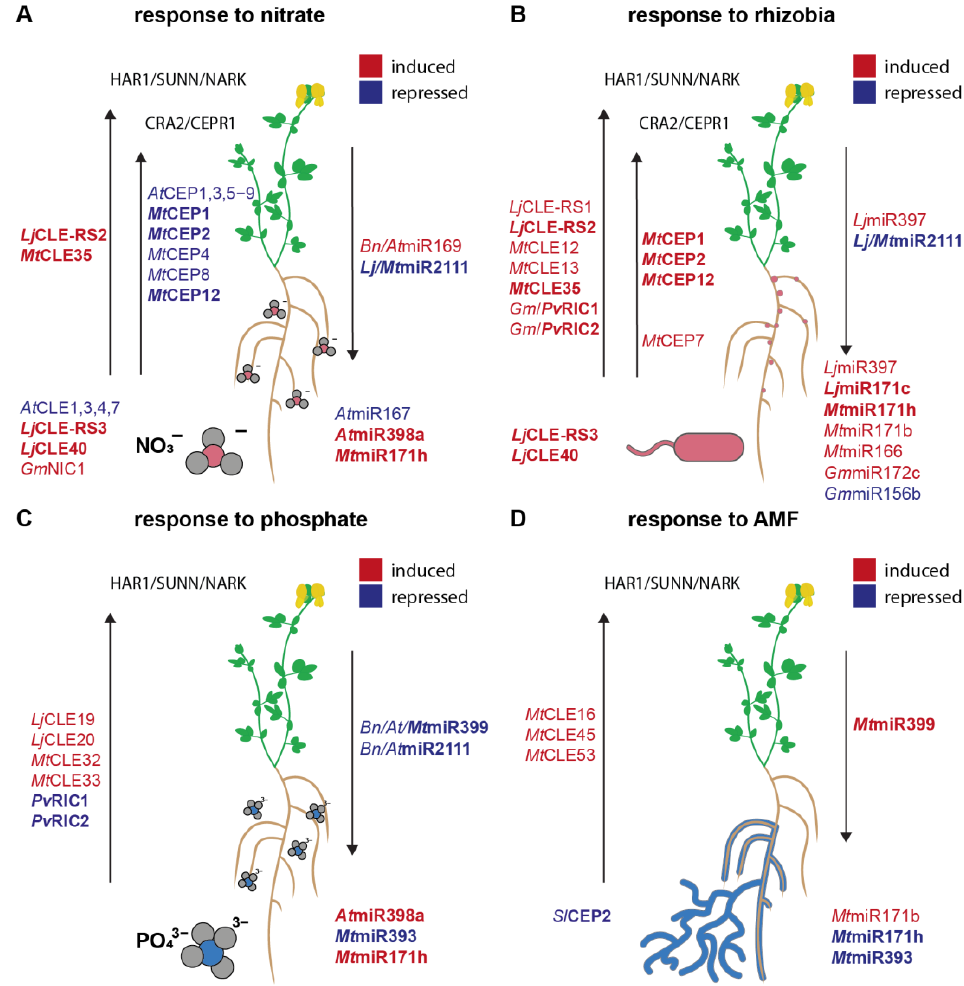
Figure 1. Nutrient homeostasis and acquisition mechanisms involve regulation by peptide hormones and miRNAs. CLE and CEP peptides and miRNAs responding to ( A ) N availability, ( B ) rhizobia , ( C ) P availability and ( D ) arbuscular mycorrhizal fungi. Molecules that are induced or repressed by a respective stimulus are displayed in red or blue, respectively. Molecules that are responsive to more than one stimulus are in bold. Arrows indicate shoot-to-root or root-to-shoot translocation of mobile molecules. Specific responses are mediated by the shoot localized leucine-rich repeat receptor-like kinases HAR1/SUNN/NARK and CRA2/CEPR1. Lj , Lotus japonicus ; Mt , Medicago truncatula ; At , A. thaliana ; Bn , Brassica napus ; Gm , Glycine max ; Pv , Phaseolus vulgaris ; Sl , Solanum lycopersicum .